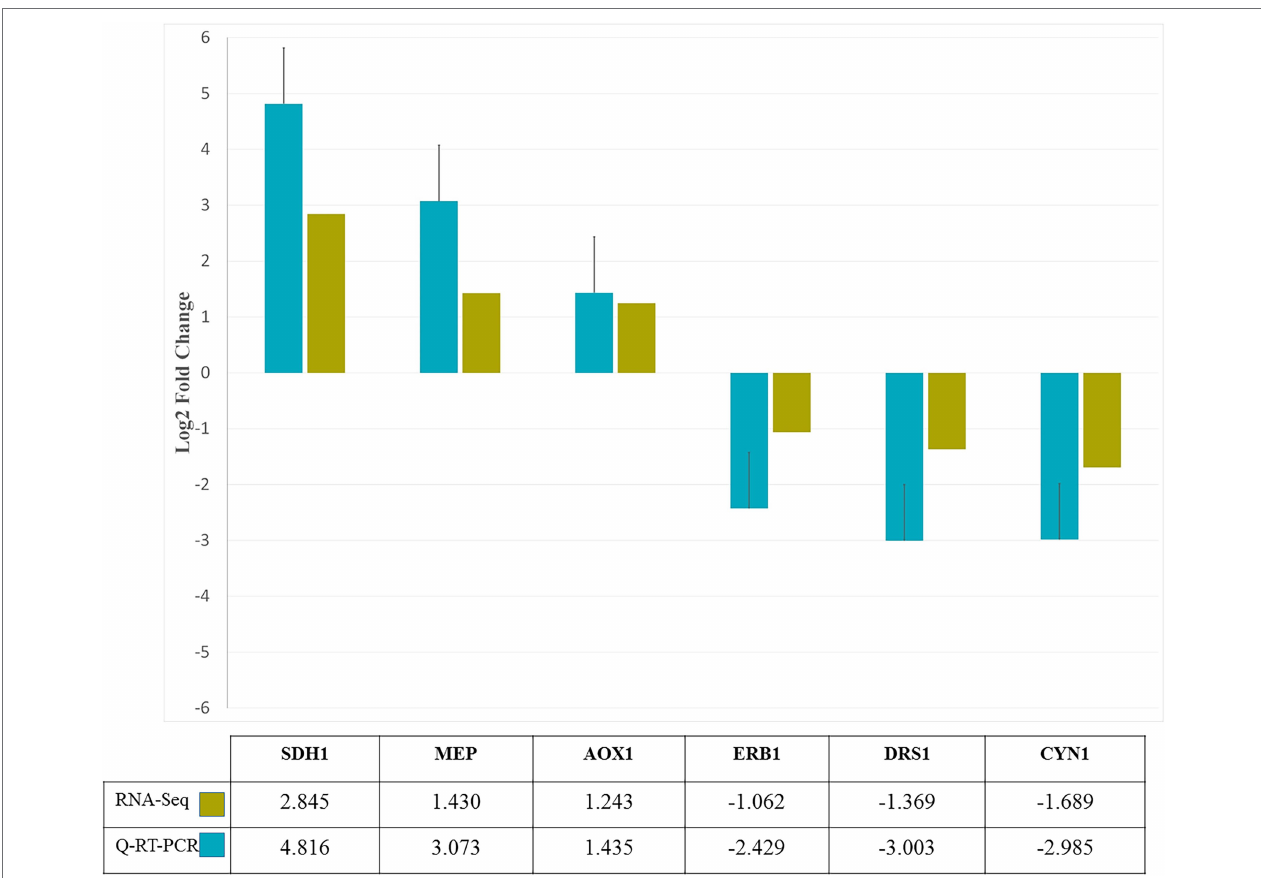
FIGURE 7 | q-RT-PCR confirmation of six genes randomly selected from RNA-Seq analysis. Based on log2-fold change levels, the expression patterns of six genes in response to zinc oxide nanoparticles were